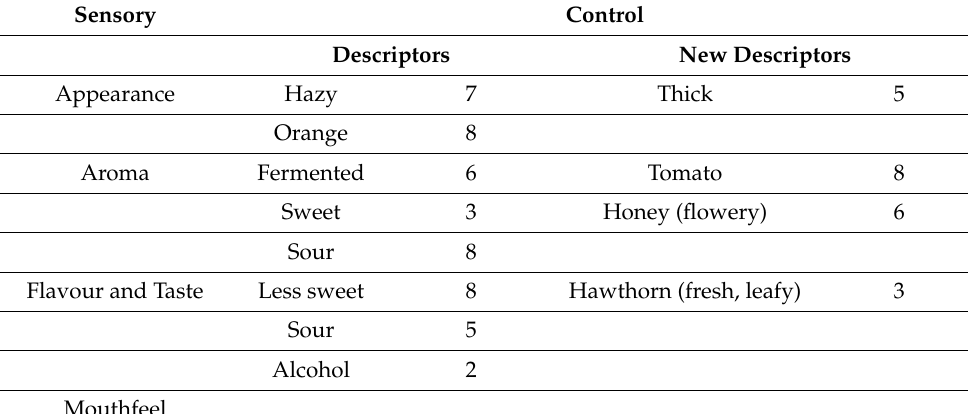
Table 3. The results from the sensory focus group of eight panellists. The descriptors were based on the commercial Kombucha beverages, and the new descriptors were from the control Kombucha sample.